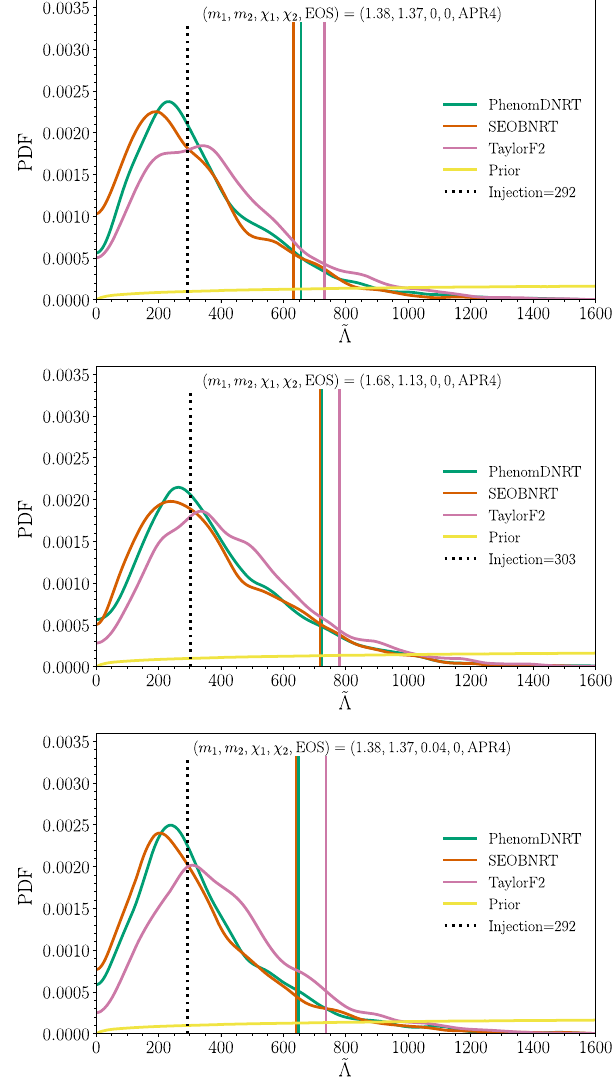
˜ Λ FIG. 14. Marginalized PDF of for the three aligned-spin waveform models using the high-spin prior of χ i < 0 . 89 . As in Fig. 11, the PDF is reweighted by the prior. The SEOBNRv4T model was injected into zero-noise data with a network SNR of 32. The injected tidal parameter shown by the dotted vertical line was calculated with the APR4 EOS. Top panel: Approximately equal mass and nonspinning. Middle panel: Unequal mass and nonspinning. Bottom panel: Approximately equal mass and primary component spinning. Solid vertical lines represent the 90% upper limit for each